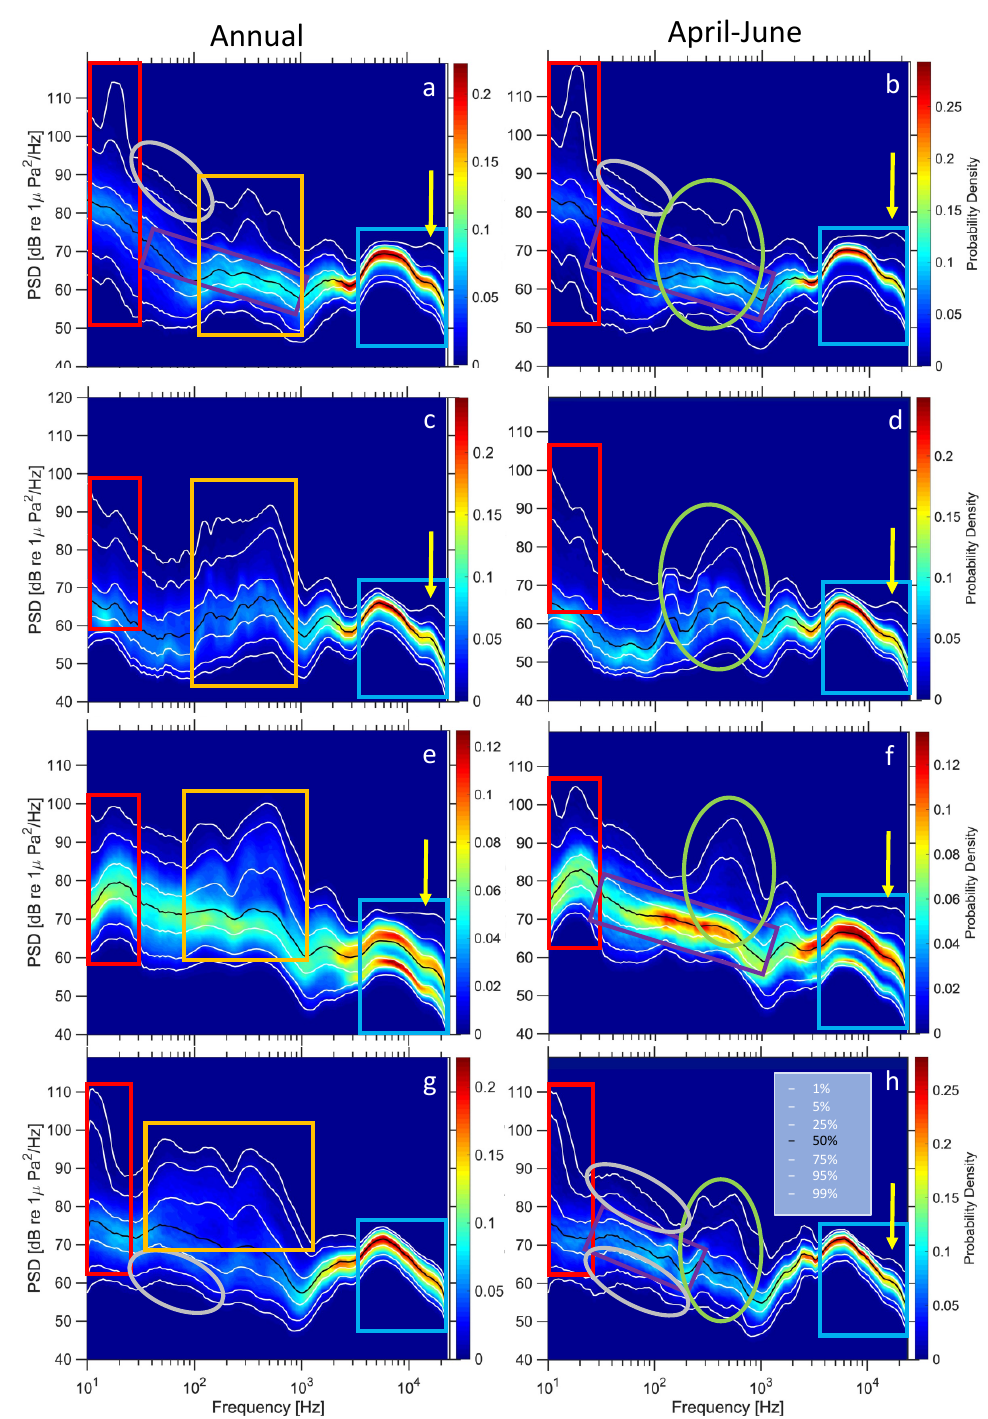
Figure 7. Power spectral density (PSD) percentile and power spectral probability density (PSPD) plots for SF ( a , b ), AB1 ( c , d ), AB2a ( e , f ), and AB2b ( g , h ) from top to bottom, respectively. Left panels are based on annual data, right panels are based on data for the same year, but only from April to June. Flow noise (red boxes), wind (purple boxes), combined biophony (i.e., squid, fish, and humpback whales overlapping in frequency: orange boxes), snapping shrimp (blue boxes), and dolphin buzzes (yellow arrows) were the main contributors to measured sound levels. Biophony between 100 Hz and 1 kHz in April-June was dominated by fish choruses (green ellipses). Vessels contributed to sound levels at all sites but could only be identified in plots for SF ( a , b ) and AB2b ( g , h : grey